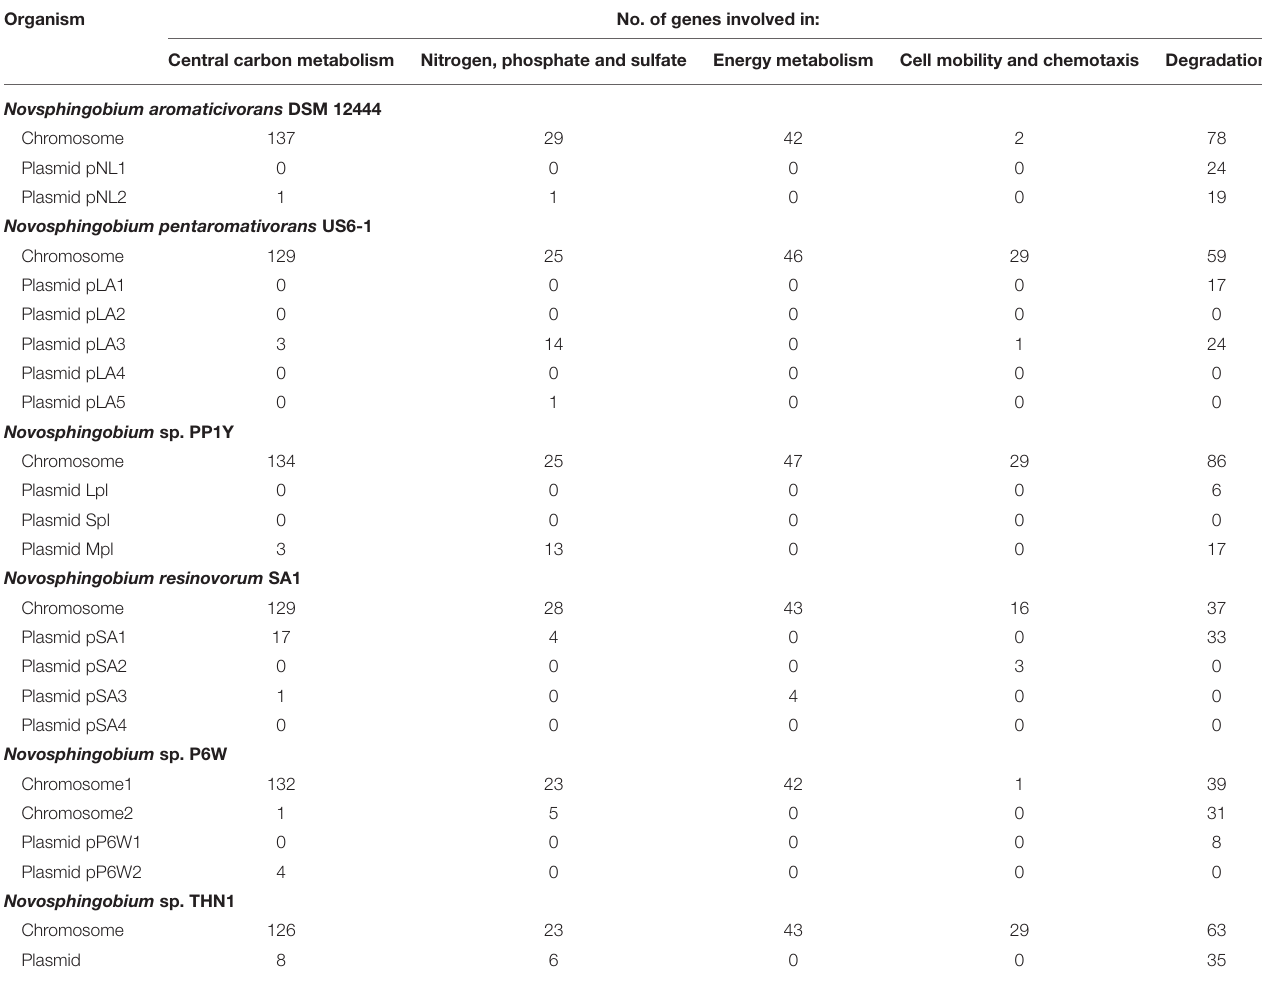
TABLE 3 | Number of genetic elements involved in metabolic pathways in the six complete Novosphingobium genomes. Organism No. of genes involved in: Central carbon metabolism Nitrogen, phosphate and sulfate Energy metabolism Cell mobility and chemotaxis